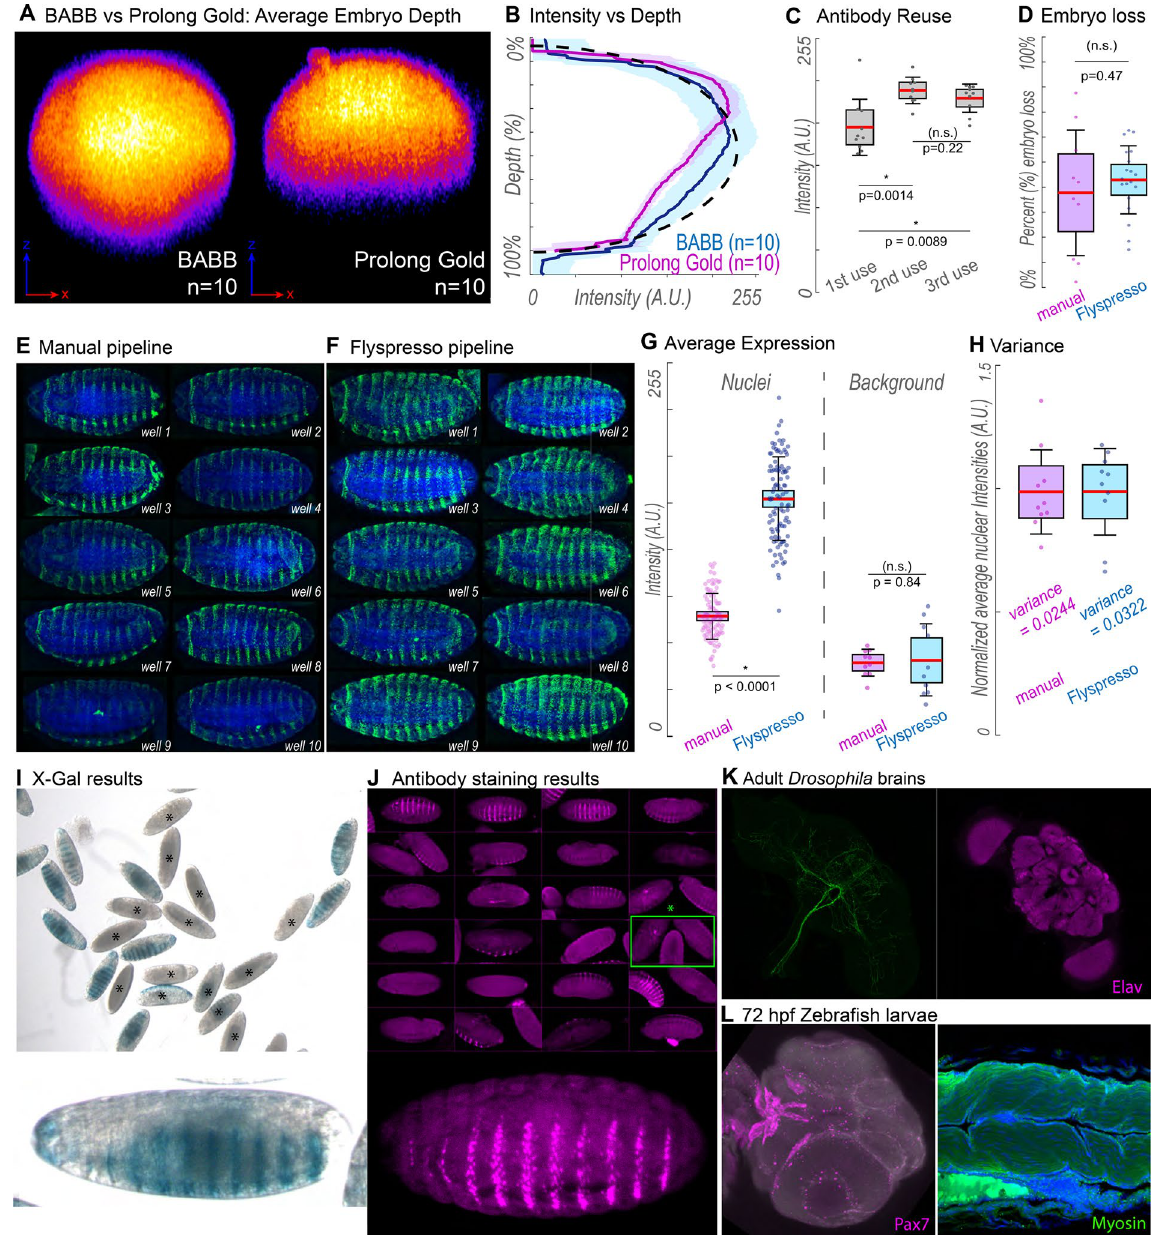
Figure 4. Expected results. ( A ) Resliced z-stacks along the x–z axis. 10 Embryos were composited together for each image. Embryos were either mounted in BABB (left) or Prolong Gold (right). ( B ) Signal intensity going through the mounted embryos—BABB (blue) and Prolong Gold (magenta). Solid colored line indicates the mean, lightly shaded regions are +/− 1 standard deviation. The black dotted line represents the hypothetical shape of an embryo without fluorescent decay. ( C ) Box plots comparing fluorescence intensity after reusing antibody solutions. Each point represents the average expression of an individual embryo (N = 10 embryos per condition). ( D ) Box plots comparing the amount of embryos lost during fixation using manual conditions (magenta, N = 10) or Flyspresso (blue, N = 19). Each point represents the percent loss from a single fixation. ( E ) Single representative embryos from 10 embryo pools using manual conditions and ( F ) the Flyspresso pipeline. ( G ) Box plots for the average nuclear intensity (left) and background intensities (right). Left: each point represents the average nuclear expression for a single embryo (N = 10 pools, n = 10 embryos per pool, 100 points total) between the manual pipeline (magenta) and the Flyspresso pipeline (blue). Right: the average intensity between the stripes for each represented embryo shown in panels e and f for the manual pipeline (magenta, N = 10) and the Flyspresso pipeline (blue, N = 10). ( H ) Boxplots for the normalized nuclear intensities, where each point is the average nuclear intensity for each pool for manual methods (magenta, N = 10 pools) and the Flyspresso pipeline (blue, N = 10 pools). ( I and J ) Reporter construct variant 173-2 for the E3N enhancer. ( I ) X-gal staining overview image for 173-2. Black asterisks (*) indicate embryos not at developmental stage 16 or not in the ventral orientation. ( J ) Antibody staining with Flyspresso overview image for 173-2. Green box indicates embryo clustering. ( K ) Adult Drosophila brain co-stained with a neuronal reporter and Elav. ( l ) 72hpf Zebrafish embryo stained with Flyspresso for Pax7 (left, magenta) and Myosin (right, green). For all box plots, the red line is the mean, light gray box is the Standard Error Mean (95% Confidence interval) and the whiskers +/− 1 standard deviation. p values are for a Student two-tailed